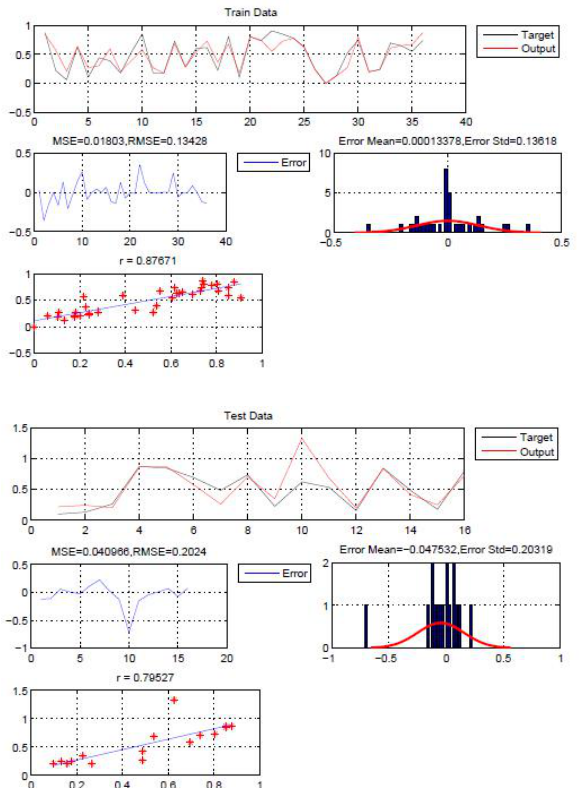
Figure 3. Top : The training results of ANFIS. Bottom : The test results of ANFIS